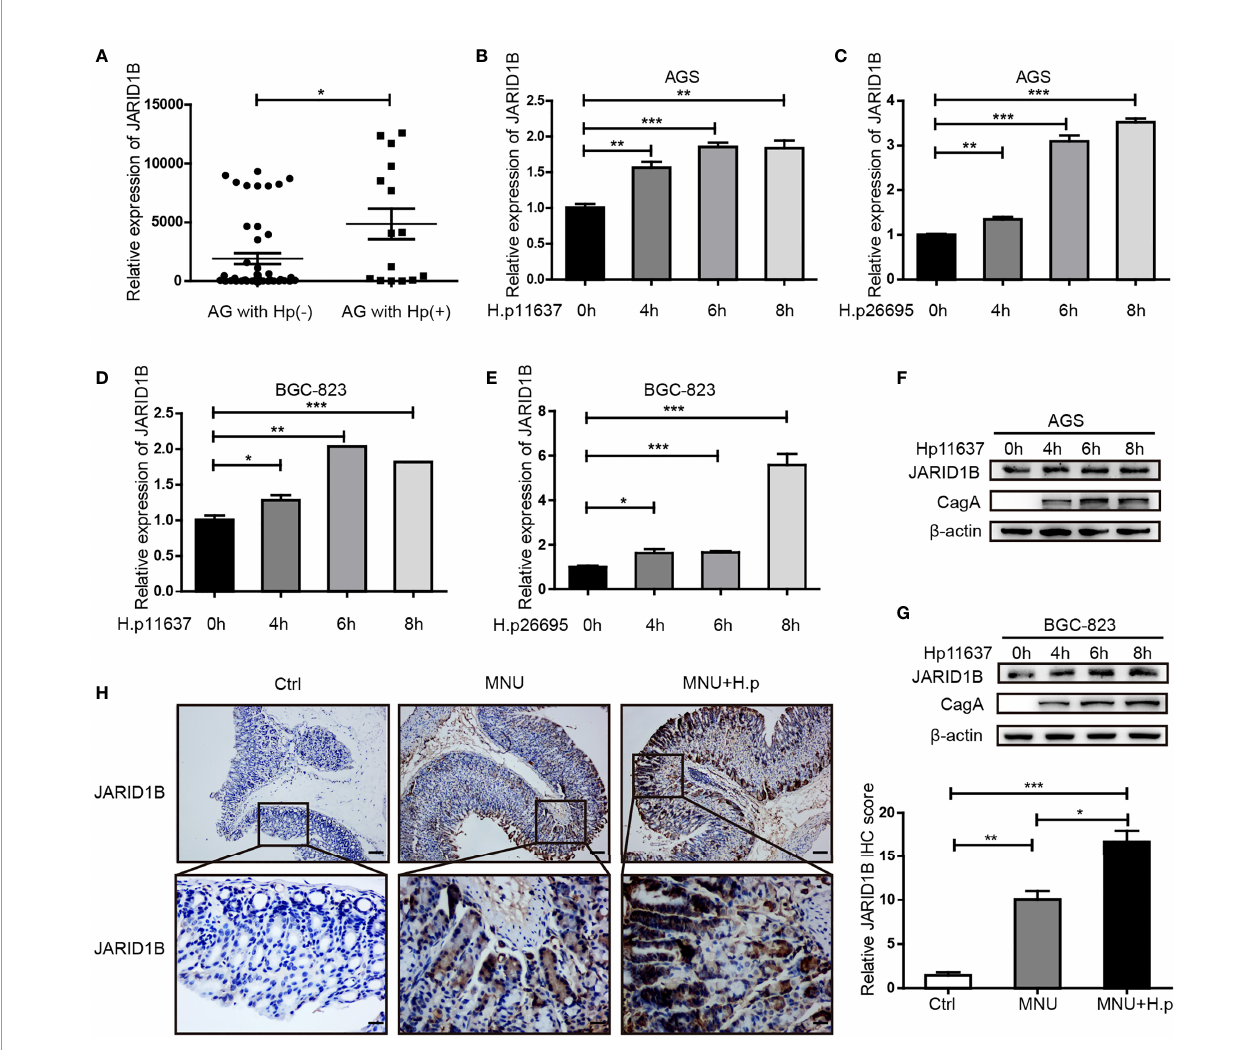
FIGURE 4 | H. pylori promotes the expression of JARID1B in gastric cancer (GC). (A) JARID1B expression was analyzed in gastritis tissue with H. pylori positive or negative by RT-qPCR. (B – E) Real-time quantitative PCR (RT-qPCR) was used to detect JARID1B messenger RNA (mRNA) in AGS and BGC-823 cell lines treated with different strains of H. pylori at different time points, *P < 0.05, **P < 0.01, ***P < 0.001 by Student ’ s t-test. (F, G) Western blot was used to detect the protein levels of JARID1B in AGS and BGC-823 cells incubated with H. pylori strains (11637) at different time points. (H) Immunohistochemical staining analysis of JARID1B expression in gastric tissue of control group, low-dose MNU gavage group, and H. pylori (SSI) combined with low-dose MNU gavage group. Representative images are shown here (magni fi cation: ×100, ×400; scale bars: 200 and 50 m